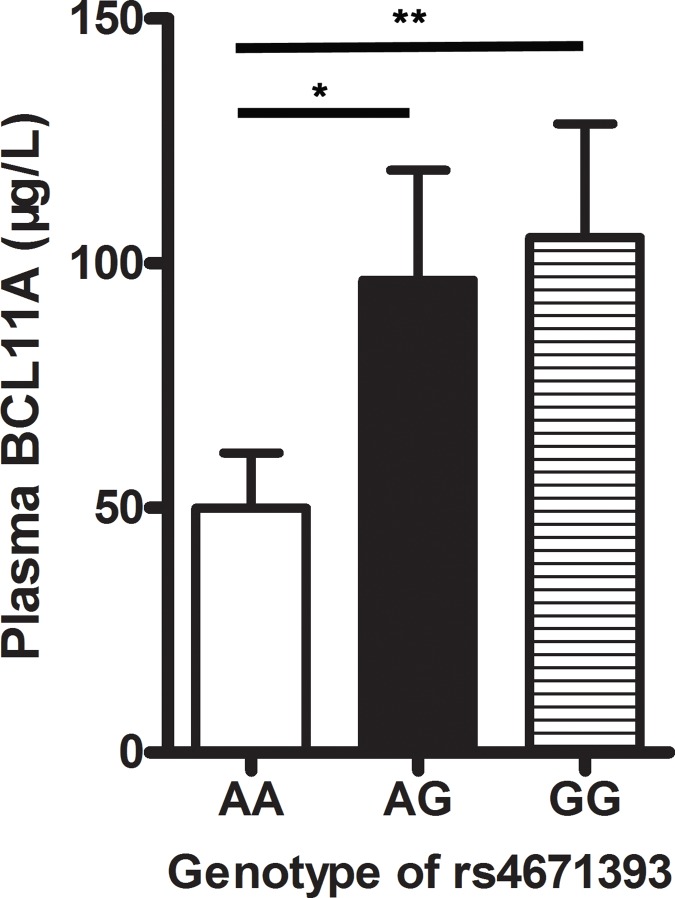
Plasma BCL11A concentrations in different rs4671393 genotypes, *P < 0.05, **P <0.01.